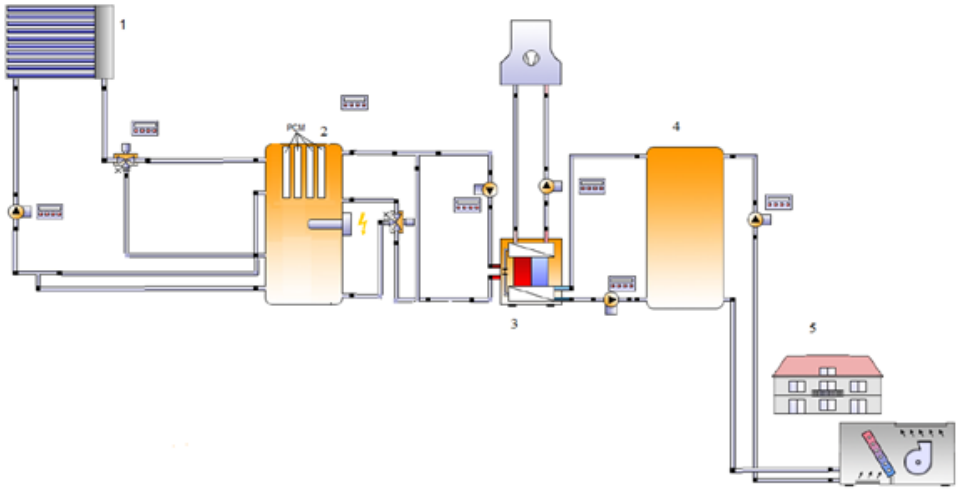
Figure 1. Scheme of solar cooling